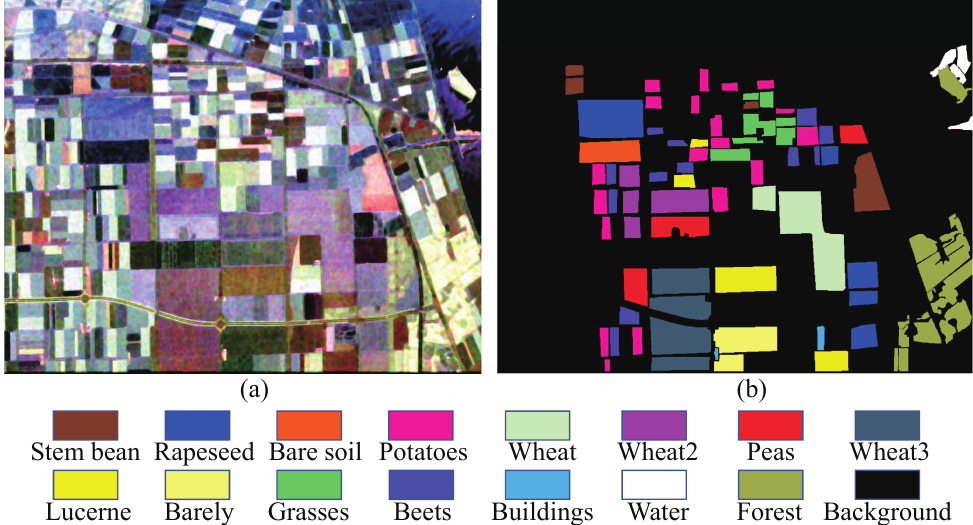
Figure 5. Flevoland dataset. ( a ) PauliRGB image (Red: double-bounce scattering power. Green: volume scattering power. Blue: surface scattering power). ( b ) Ground truth map.